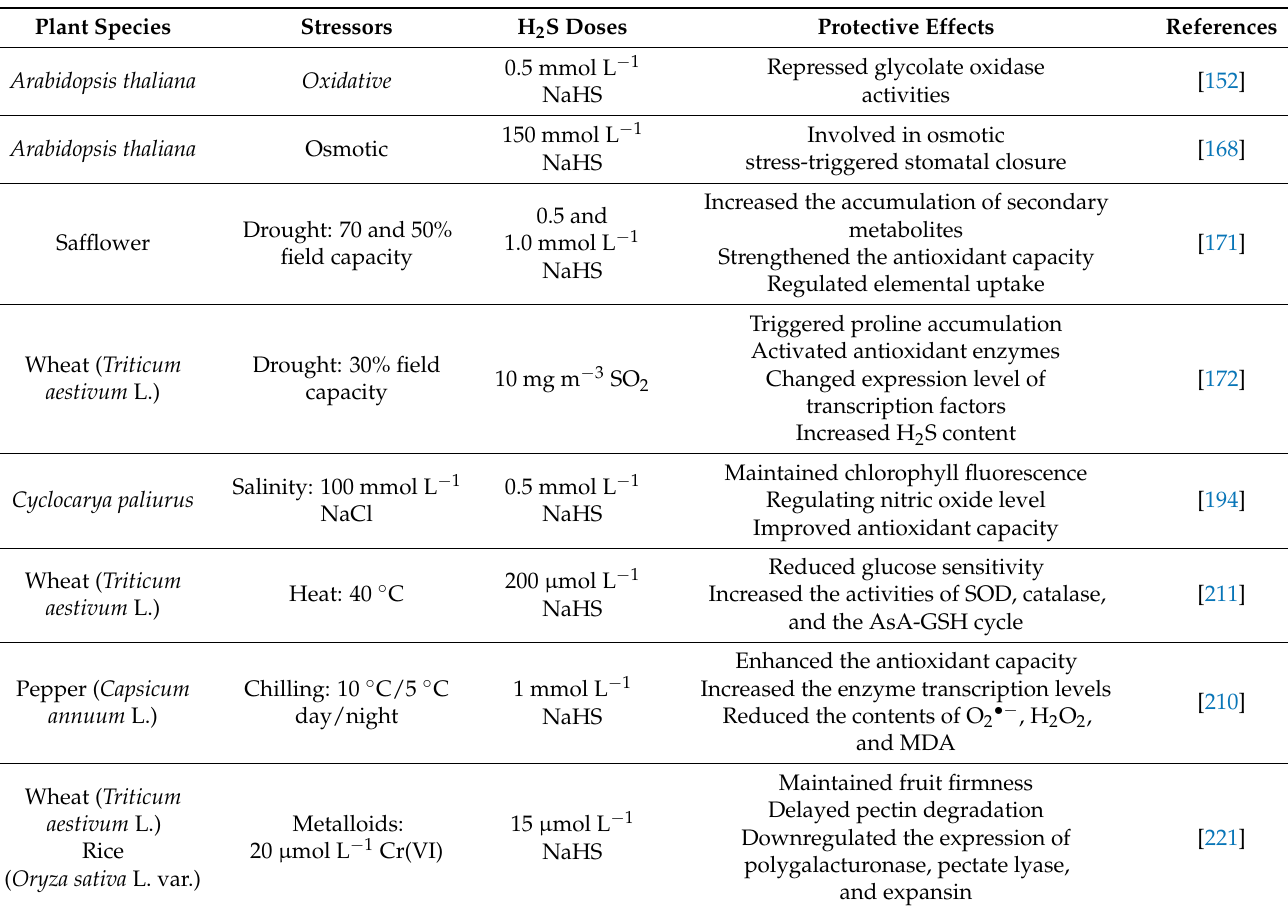
Table 2. H 2 S improves plant stress